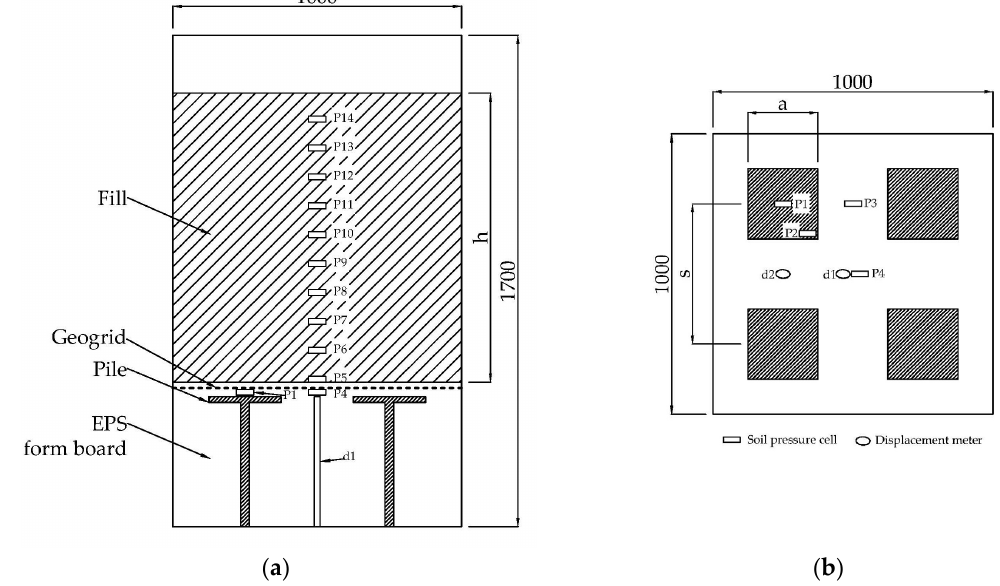
Figure 2. Layouts of test setup (unit: mm), ( a ) Side view; ( b ) Top view. (h is the embankment height; a is the width of the pile cap; s is the pile